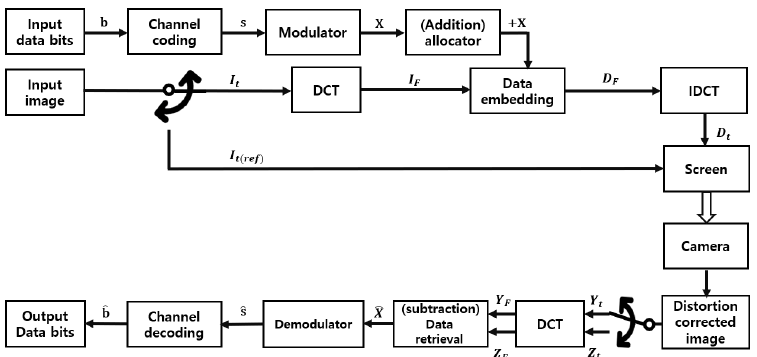
Figure 1. Comprehensive block diagram of the proposed DFC